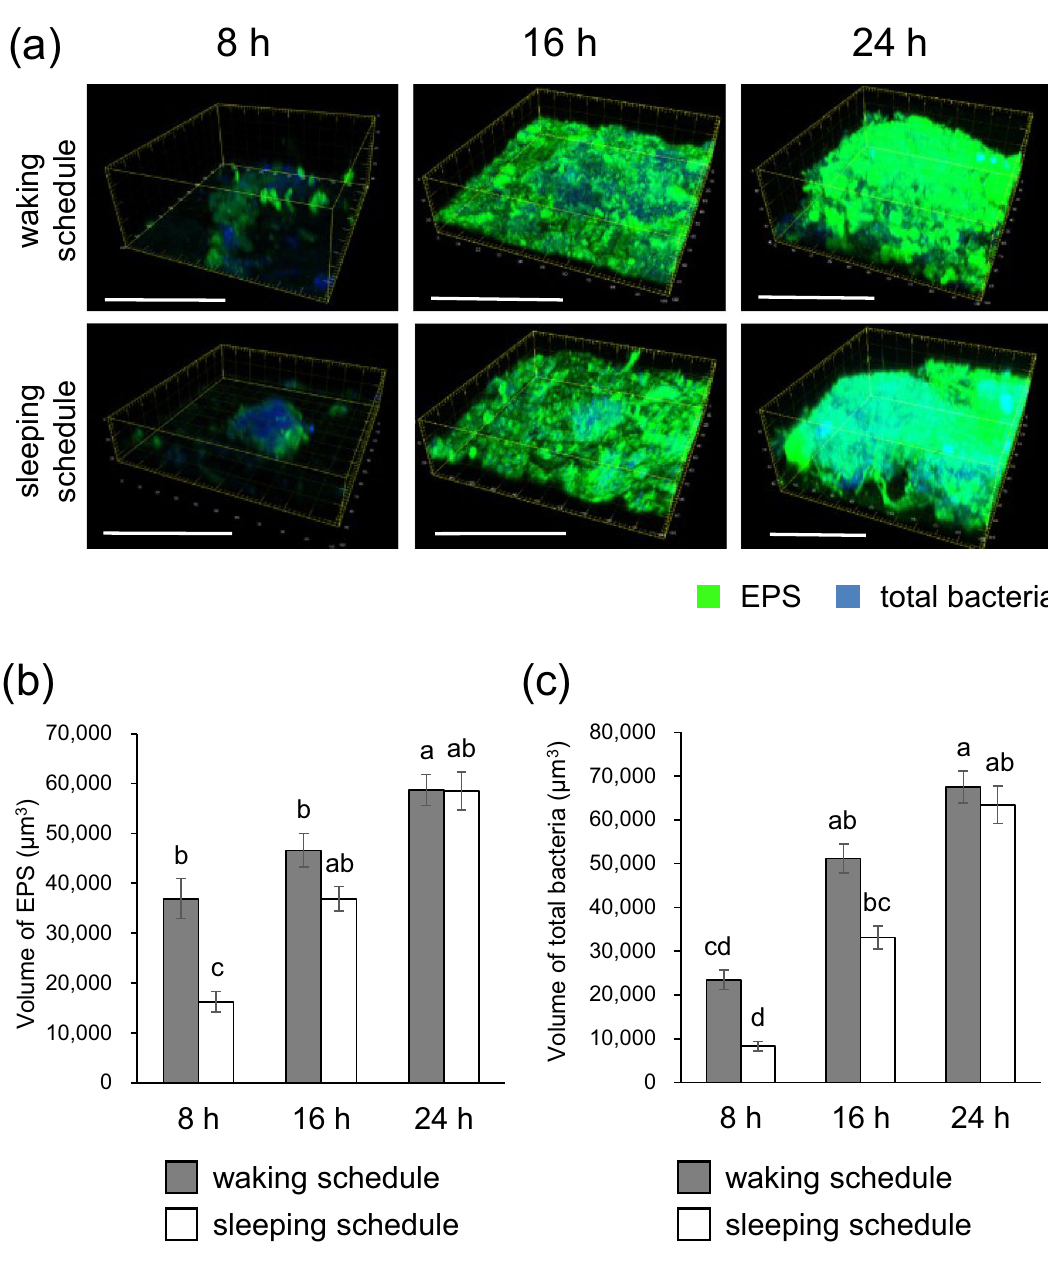
Figure 7. Confocal laser scanning microscopy images of in situ dental biofilm and the volumes of components in EPS-total bacteria staining. ( a ) Exopolysaccharide (EPS) labeled with FITC-ConA and FITC-WGA is depicted in green, and total bacteria labeled with DAPI are depicted in blue. ( b , c ) The volumes of EPS ( b ) and total bacteria ( c ). Significant differences are represented by different letters (Friedman’s test, p <